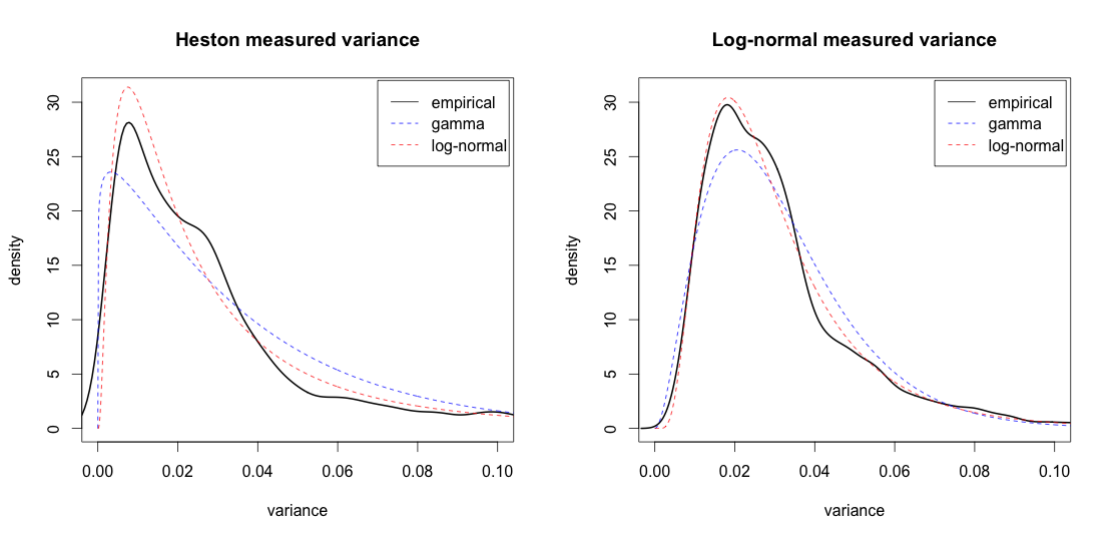
Figure 2. Fitted empirical, log-normal and gamma densities to measured variance with λ = 0.94 of 4532 simulated prices with Heston’s ( left figure) and the log-normal model ( right